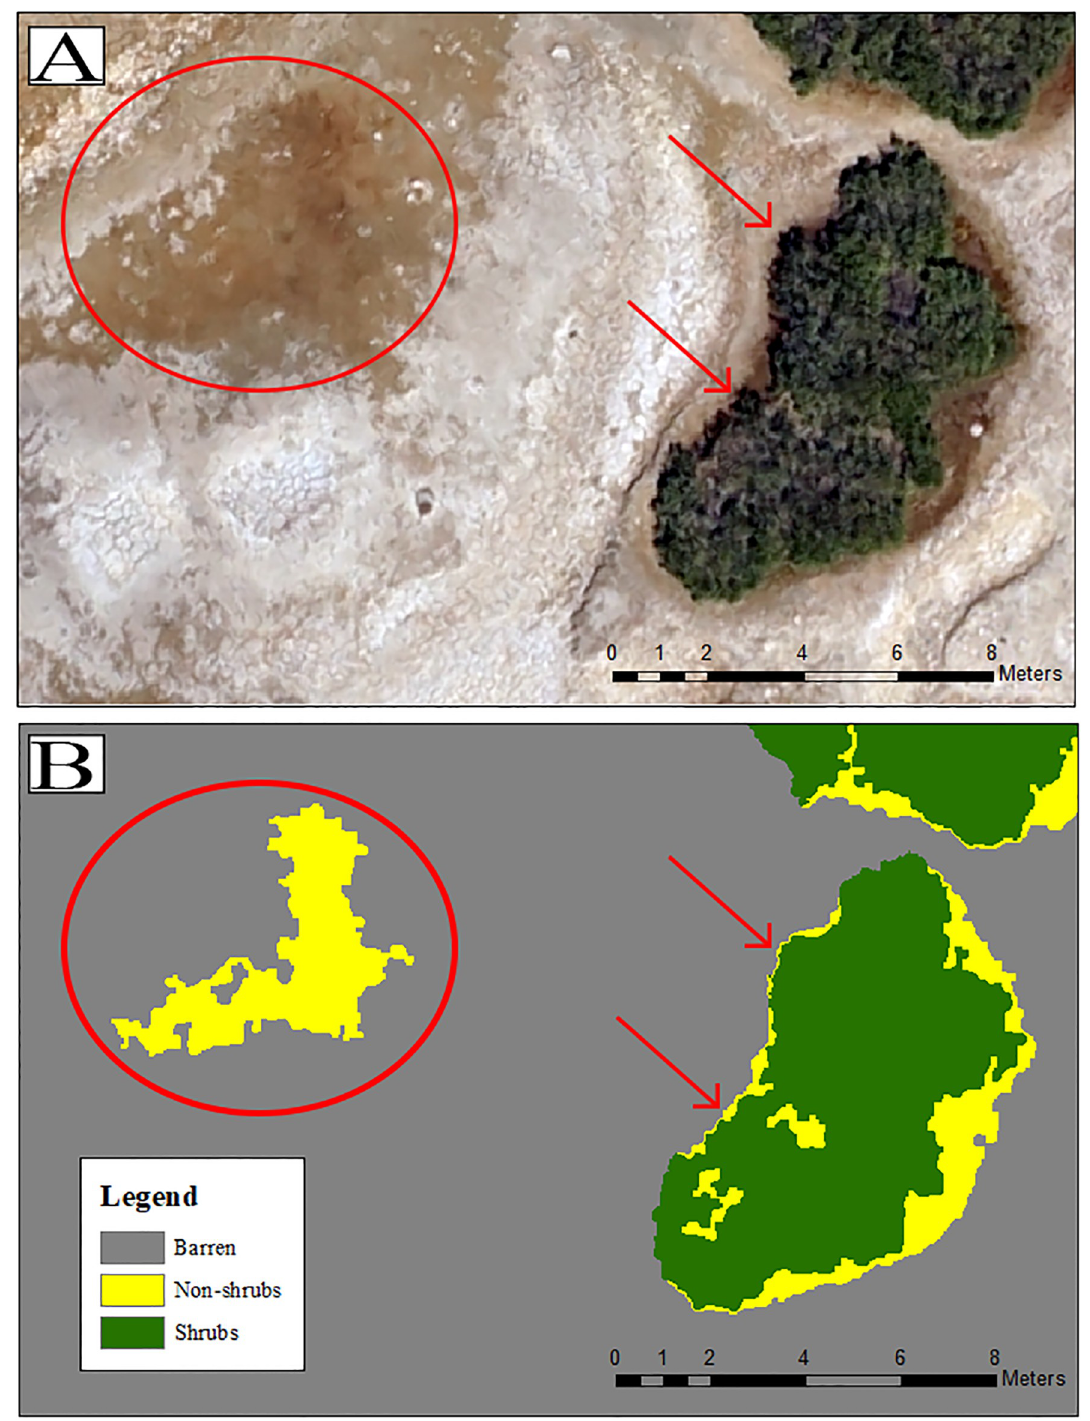
Fig 2. Comparisons between RGB drone imagery and classified product. (A) Example RGB imagery at 120 m AGL (B) final classified image. Post processing tools failed to eliminate the patch of darker barren surface and incorrectly classified the patch as non- shrub vegetation (indicated by the red circle). Shadows along the edge of the vegetation patch were improperly classified as shrubs (indicated by red arrows).